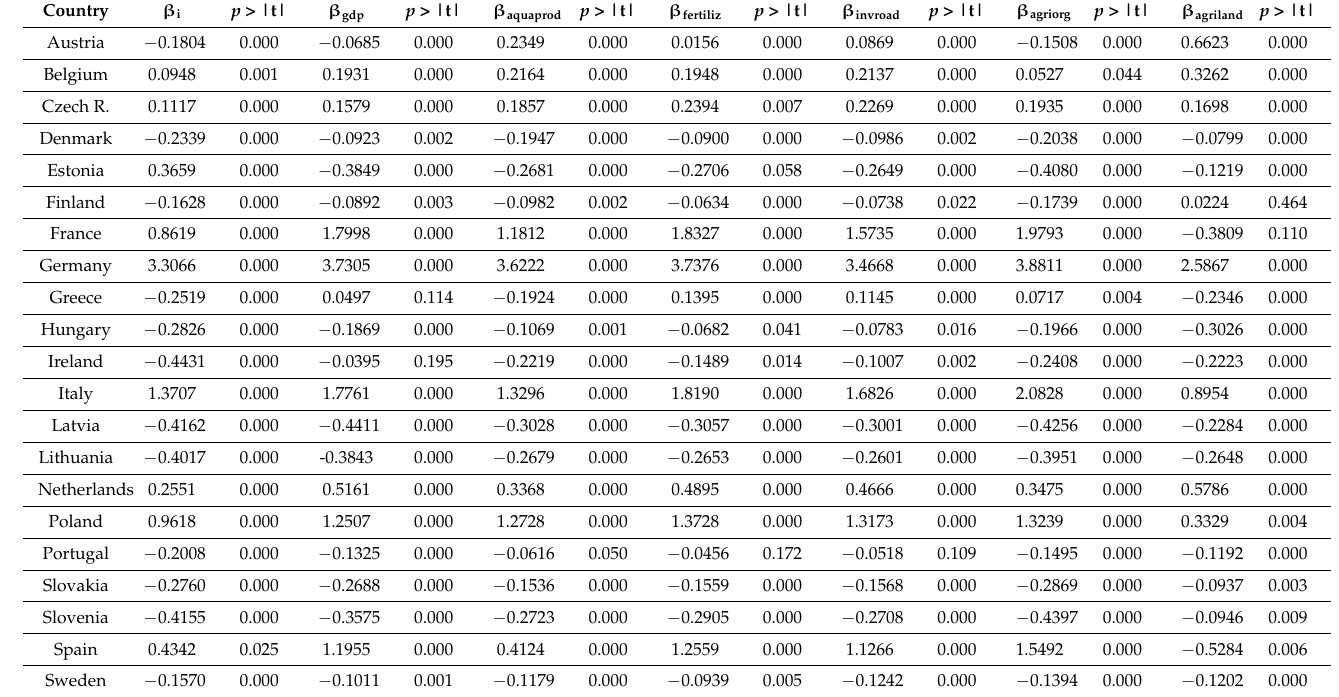
Table 2. The variable’s influence on the pollution reduction in temporary dynamics by